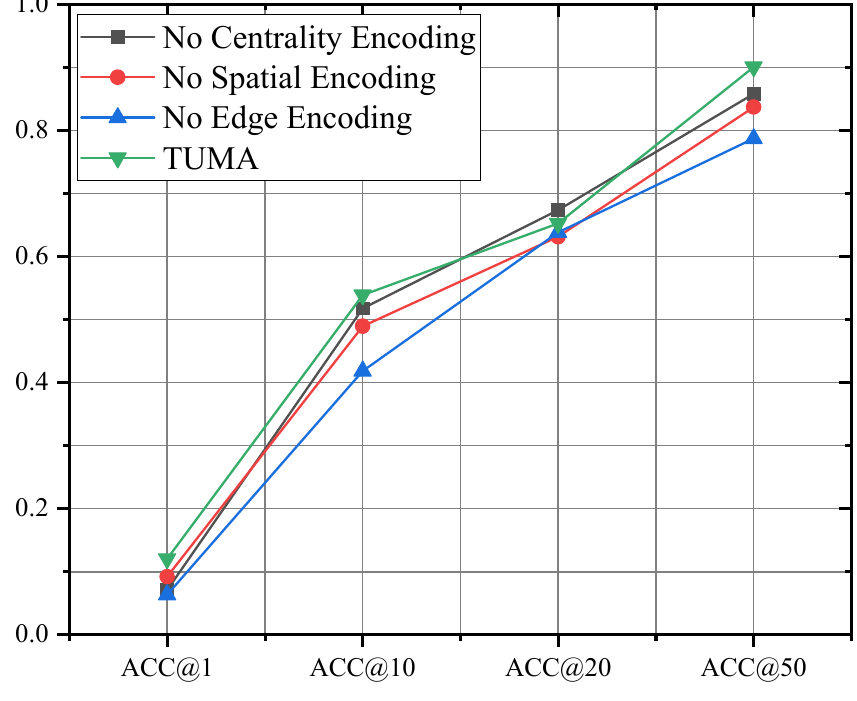
Figure 5. The accuracy of ablation experiments on the Weibo–Douban dataset.